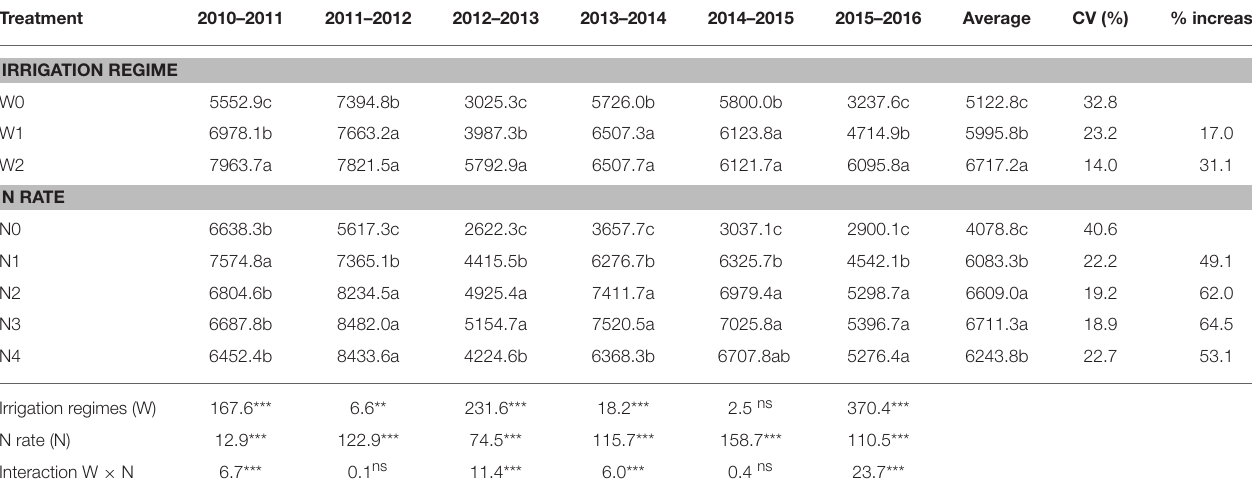
TABLE 2 | Mean wheat grain yields for irrigation treatments across N rates and for N rates across irrigation treatments (kg ha − 1 ) and F -values from analysis of variance for the 2010–2011 to 2015–2016 growing seasons.